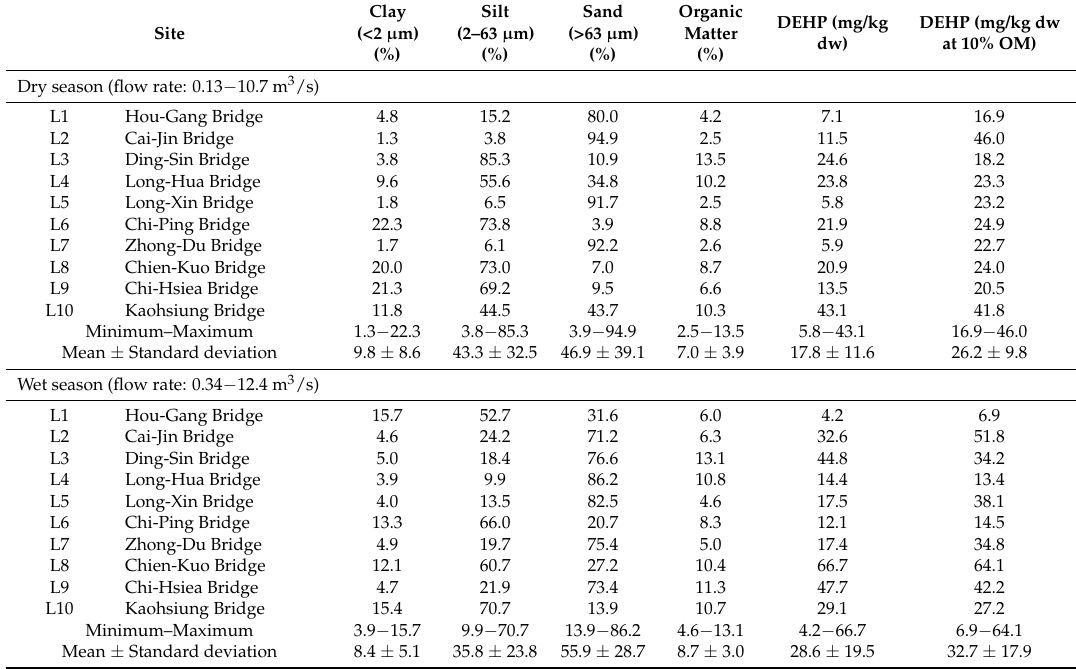
Table 1. The distribution of grain size, organic matter (OM) content, and DEHP levels in the sediments of Love River during the dry season and the wet